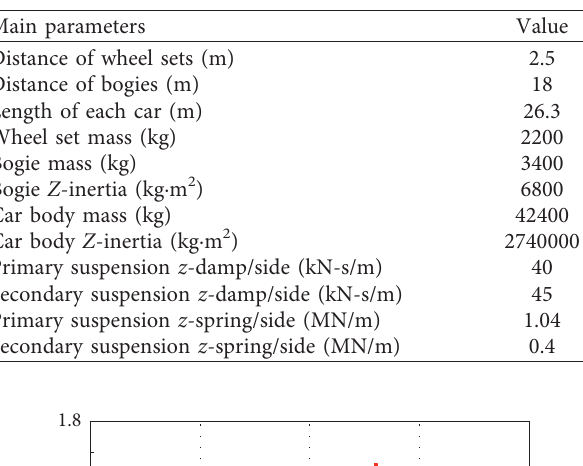
Table 2: Vehicle parameters.